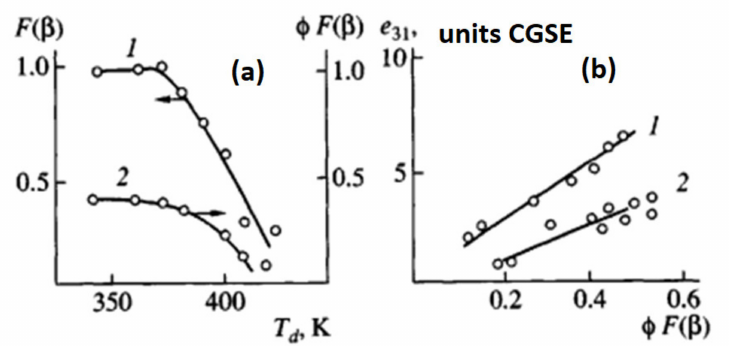
Figure 16. Change in the proportion of the β -phase F( β ) in its mixture with the α -phase in the PVDF film (1) and the product of the degree of crystallinity ϕ by F( β ) (2) as a function of Td with the drawing ratio λ = 4 ( a ), as well as the dependence of the piezoconstant e31 on ϕ F( ϕ ) after uniaxial drawing of the film (1) and its subsequent isometric annealing (2) ( b )